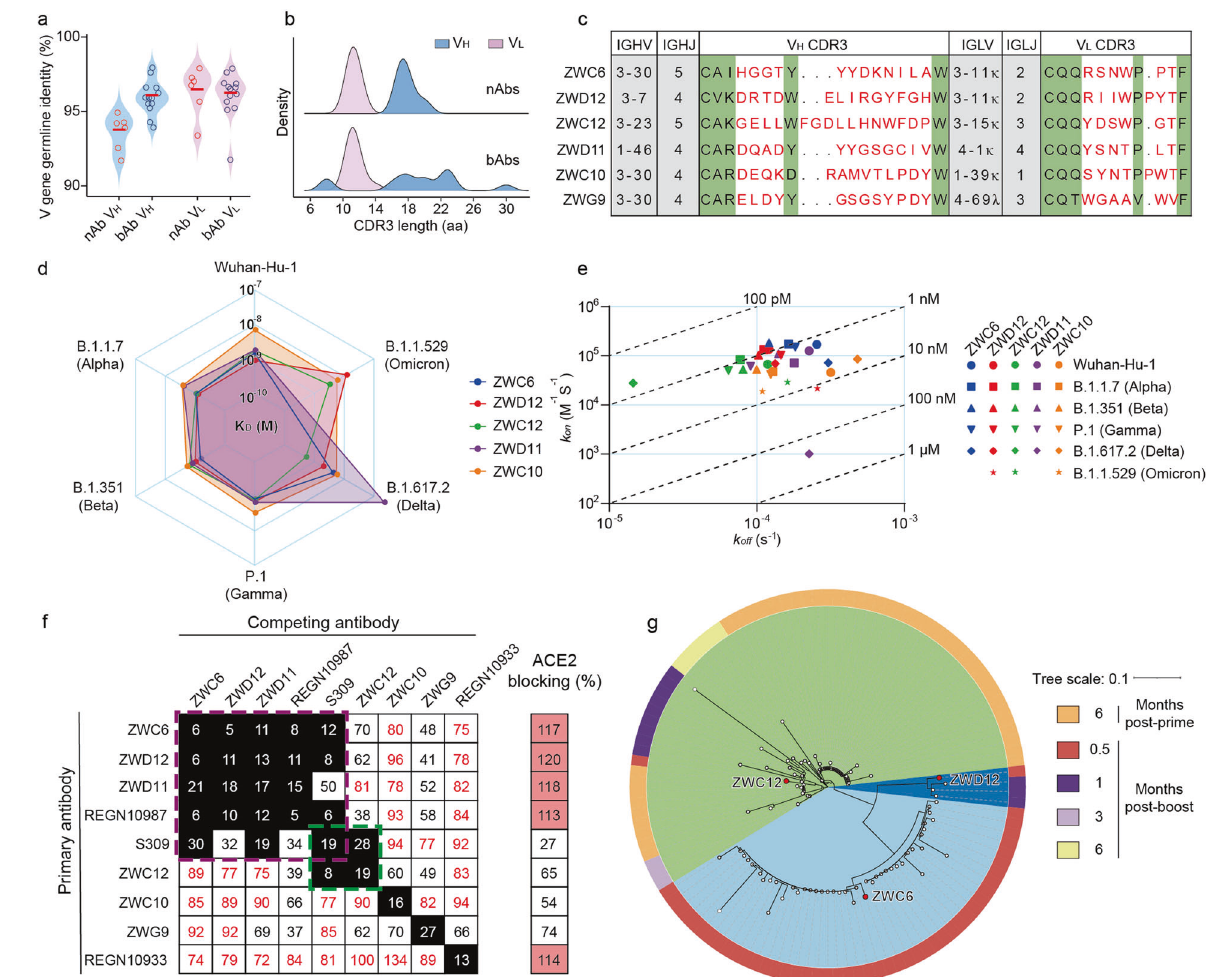
Fig. 3 Binding properties of S protein-speci fi c mAbs. a The V H and V L gene identities from the germlines of nAbs and bAbs. b CDR3 aa lengths of V H and V L of nAbs and bAbs. c The V H and V L gene usage, J gene usage, and CDR3 aa sequences of nAbs. d Binding kinetics ( K D values) of nAbs against the S proteins of SARS-CoV-2 variants as determined by SPR. e K on and K off of nAbs against the S proteins of SARS-CoV-2 variants as determined by SPR. f Heatmap showing the competing matrix of nAbs and the ability of mAbs to block the ACE2 and S-protein interaction determined by BLI. The numbers in the box indicate the percentage of binding of the competing mAb following the binding by primary antibody. The mAbs were considered competing if the inhibition percentage was <30% (black boxes with white numbers). The mAbs were deemed to be non-competing for the same site if the percentage was >70% (white boxes with red numbers). The white boxes with black numbers indicate an intermediate phenotype (30 to 70%). g The phylogenetic tree graph shows clones from the clonotype of ZWC6, ZWD12, and ZWC12 sequenced at different time 10 mg/kg ZWC6 three days in advance were able to survive lethal protein binding to ACE2 except S309. ZWC12 and S309 fell into challenge without obvious weight loss, while those in the therapeutic the same group. To investigate the evolutionary trajectories of nAbs at different time points, we searched for the heavy-chain clonotypes with the identical V genes and similar (identical CDR3 amino acid length and fi ve or less differences in absolute amino acid composition of CDR3s were considered as similar) CDRH3 in the B cell receptor (BCR) sequences at 7 time points. The ZWD12 clonotype was found only at 0.5 and 1-month post-boost, and the ZWC12 clonotype was found at 6 months post-prime and at 0.5, 1, 3, and 6 months after the boost dose; on the other hand, the clonotype of ZWG9, the nAb with the lowest binding af fi nities, was found at all 7 time points (Fig. 3g and Supplementary Fig. 6).